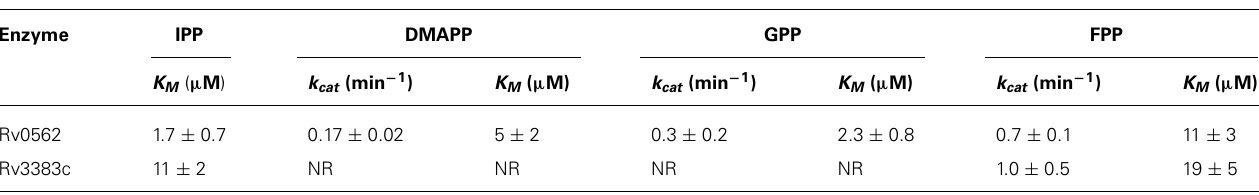
Table 1 | Kinetic analysis of confirmed GGPP